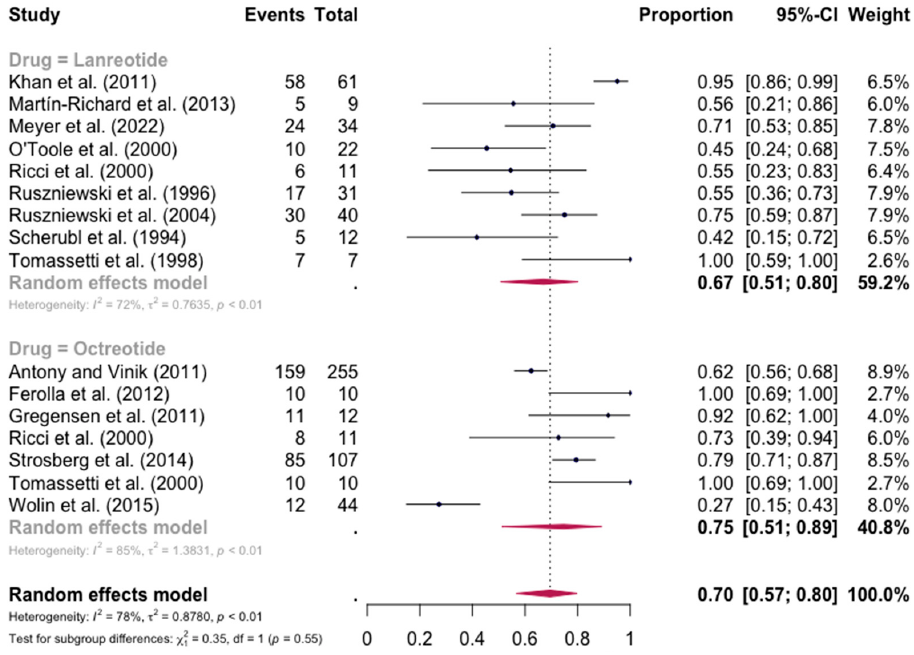
Figure 3. Forest plot showing the pooled PR and CR for diarrhea in patients with carcinoid syndrome, after excluding patients under pasireotide treatment. CI: confidence interval. p refers to Cochran’s Q test for heterogeneity [21,22,34,48–60] .